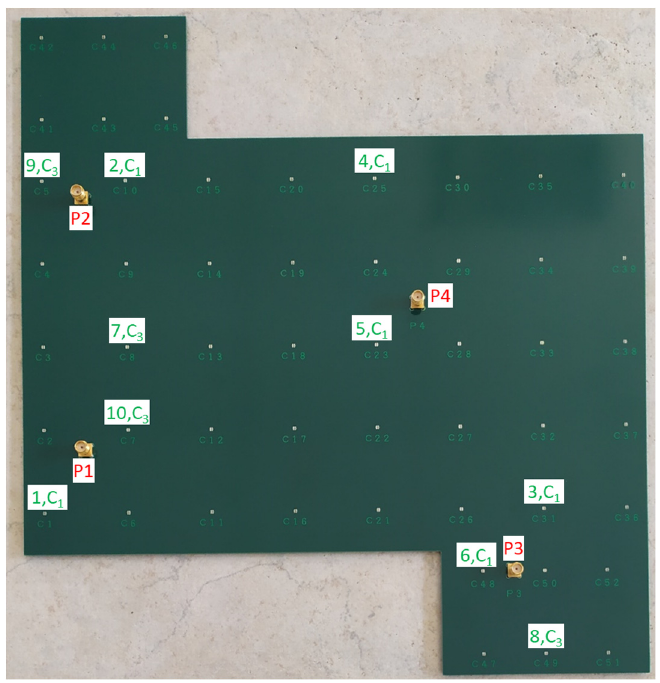
Figure 11. Manufactured board with mounted SMA connectors at the ports and decoupling capacitors.